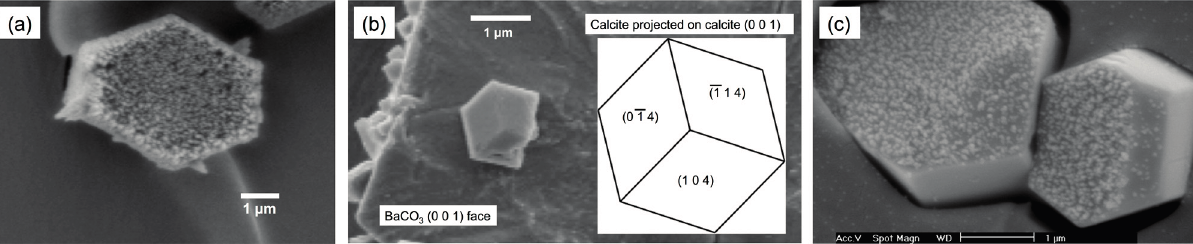
Figure 1. Scanning electron microscopy (SEM) images of ( a ) aragonite needles nucleated on SrCO 3 (shown perpendicular to the (0 0 1) plane); ( b ) calcite formed on BaCO 3 (shown perpendicular to the (0 0 1) plane) along with the simulated morphology of calcite projected on the (0 0 1) plane of calcite; and ( c ) nano-domains of calcium carbonate nucleated on SrCO 3